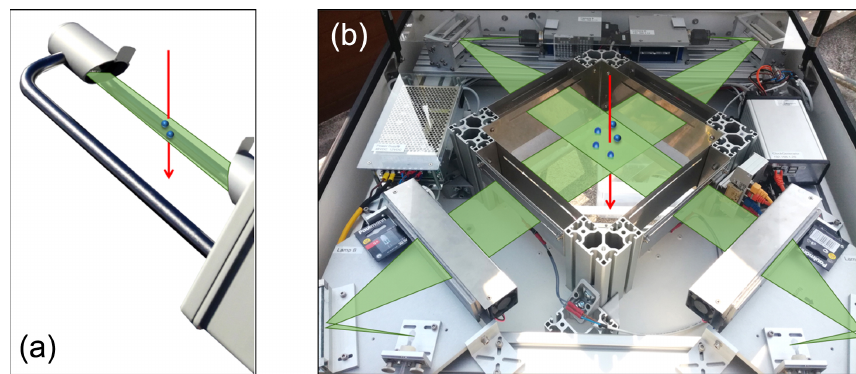
Figure 2. Comparison of the measurement principles of the Thies disdrometer (a) and the two-dimensional video disdrometer (2DVD, b ): while the Thies disdrometer measures the attenuation of an infrared laser beam (786nm) via falling particles, the 2DVD detects the shadowing of individual pixels in images taken by two optical cameras and from two